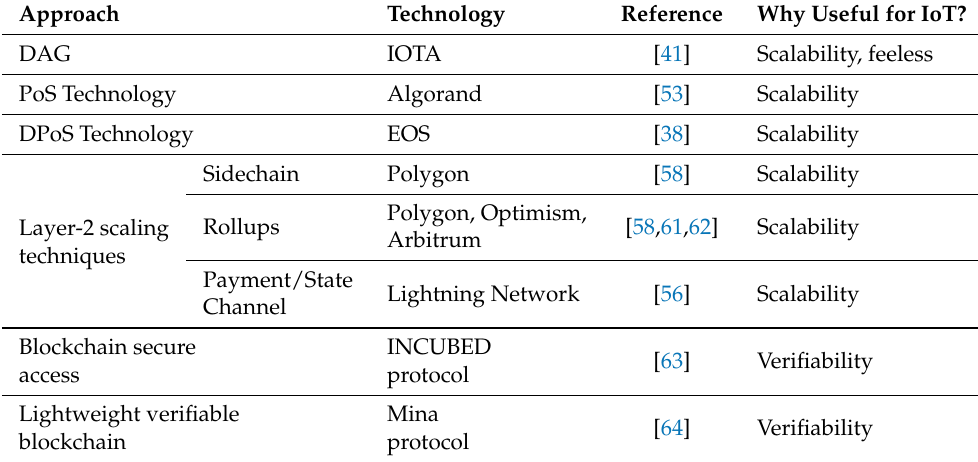
Table 2. DLT technologies adaptable with IoT